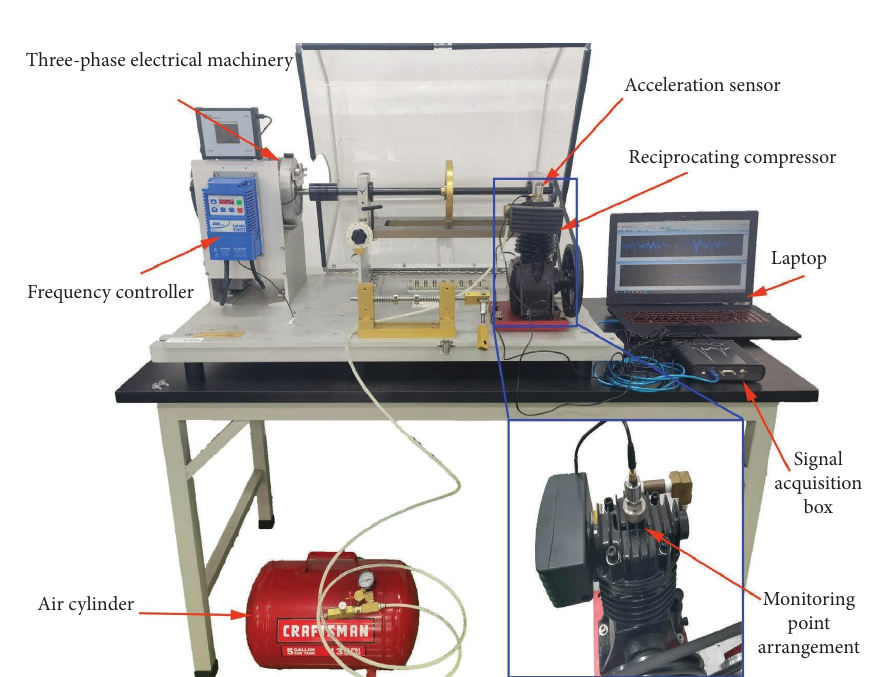
Figure 2: Technical